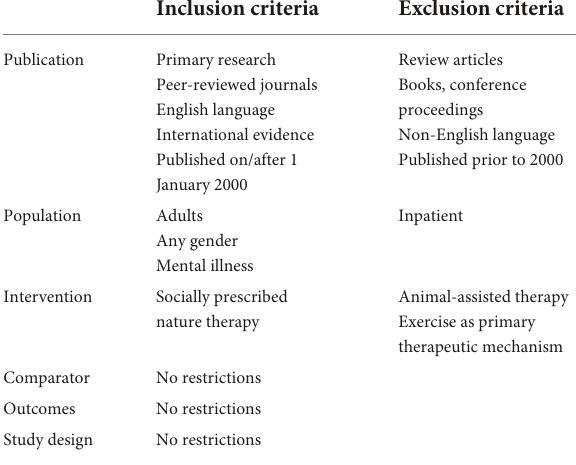
TABLE 1 Scoping review inclusion and exclusion